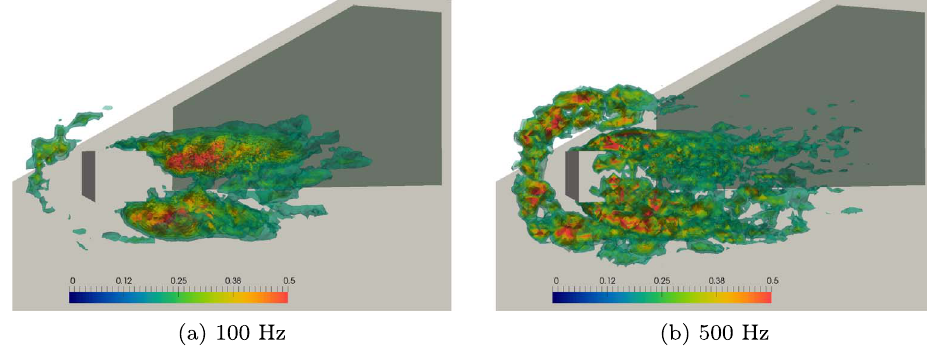
Figure 8. Iso-surfaces of acoustic source term (3) calculated by CFD simulation at different frequencies.